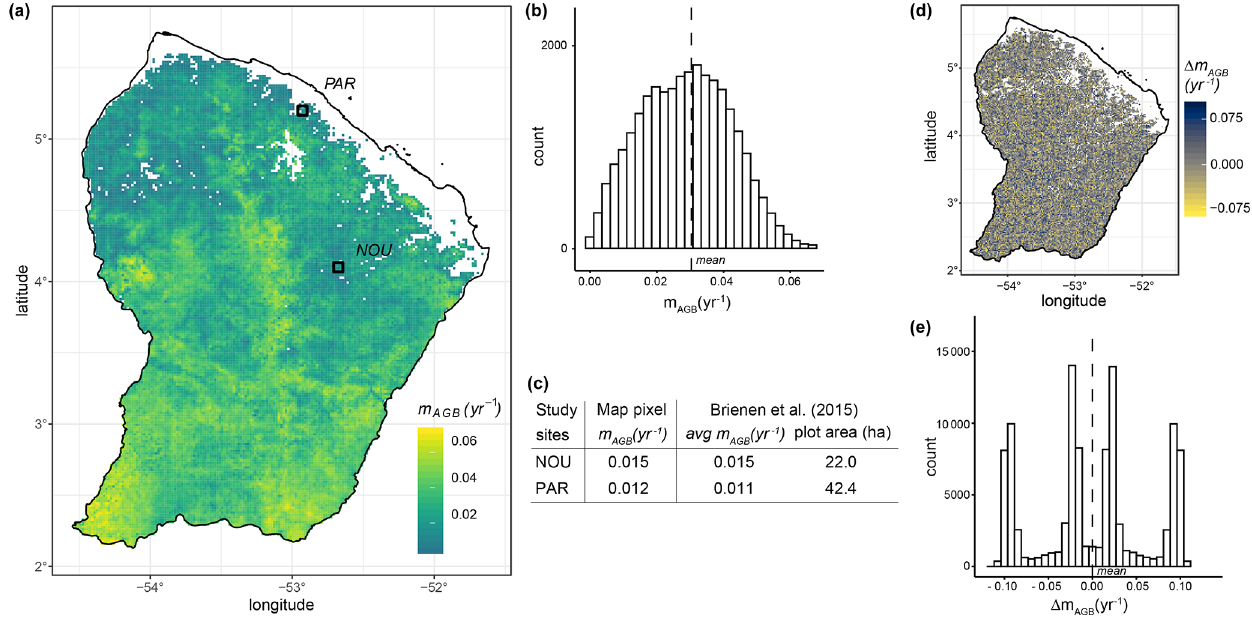
Figure 7. (a) Map of biomass loss for terra firme forests in French Guiana ( ∼ 2km resolution) and (b) its histogram. The dashed line in (b) indicates the estimated countrywide mean (3.0% with a standard deviation of 1.2%). The black squares in the map show the locations of forest plots at Paracou (PAR) and Nourage (NOU), from which (c) census data were used to compare estimated and field-based biomass loss values. The census data originate from Brienen et al. (2015). (d) Sensitivity analysis for the mapped biomass loss rates of terra firme forests in French Guiana (see Fig. 7a) and (e) its histogram. The values for the input maps of leaf area index (LAI) and forest height were randomly sampled using a uniform distribution ranging ± 30% from their original values (see Fig. S4). (cid:49)m AGB represents the variation in biomass loss rates given this variation in the input variables. For further results about the uncertainty analysis performed, see Figs. S7, S8, S9, S10, S11, and